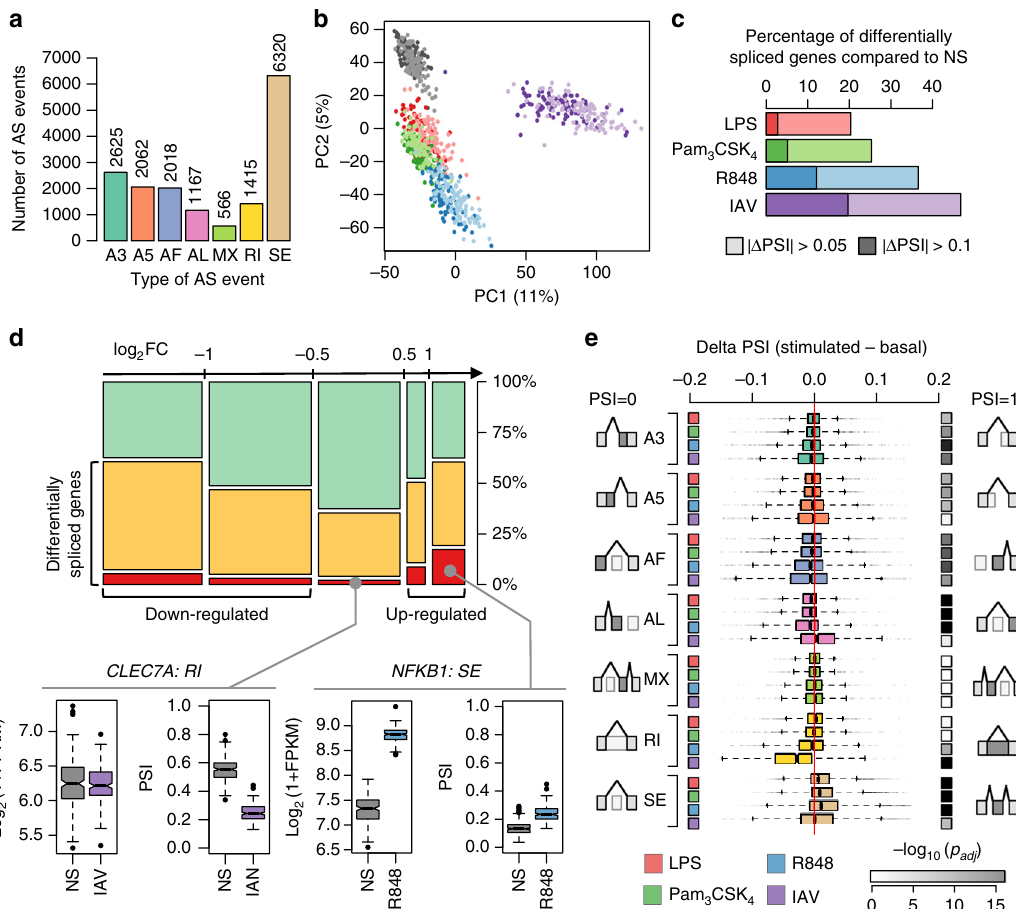
Fig. 2 Immune stimulation induces major shifts in alternative splicing (AS) patterns. a Number of detected AS events by type: A3, alternative 3 ′ splice site; A5, alternative 5 ′ splice site; AF, alternative fi rst exon; AL, alternative last exon; MX, mutually exclusive exons; RI, retained intron; SE, skipped exon. Each type of AS event is presented in a different colour that is consistently used across all fi gures. b Principal components analysis of AS events in different conditions: non-stimulated (grey), and activated with LPS (red), Pam 3 CSK 4 (green), R848 (blue) and IAV (purple). Light and dark shades represent European and African individuals, respectively. The same colour code is used for conditions, across all fi gures. c Percentage of differentially spliced genes across conditions. d Percentage of genes differentially spliced after stimulation (in at least one condition), according to maximal fold-change in gene expression upon stimulation (log 2 FC). Non-differentially spliced genes are shown in green, and differentially spliced genes in orange. Among the latter, immune response genes, as de fi ned by GO, are highlighted in red. Levels of genes expression — log 2 (1 + FPKM) — and alternative splicing — PSI — are shown for two immune genes, CLEC7A and NFKB1 , at the basal state and in the stimulation condition where the changes in isoform usage are the most pronounced (centre line, median; box limits, upper and lower quartiles; whiskers, 1.5× interquartile range; points, outliers). Boxplots are coloured according to the condition of stimulation. e Boxplots showing the shifts in PSI values, for each type of AS event and stimulus (boxplots drawn as previously). The nature of the stimuli is indicated on the left-hand side by coloured squares and signi fi cance is indicated on the right-hand side by grey squares (darker for increased signi fi cance). Boxplots are coloured according to the type of AS event considered. Source data are provided as a Source Data fi